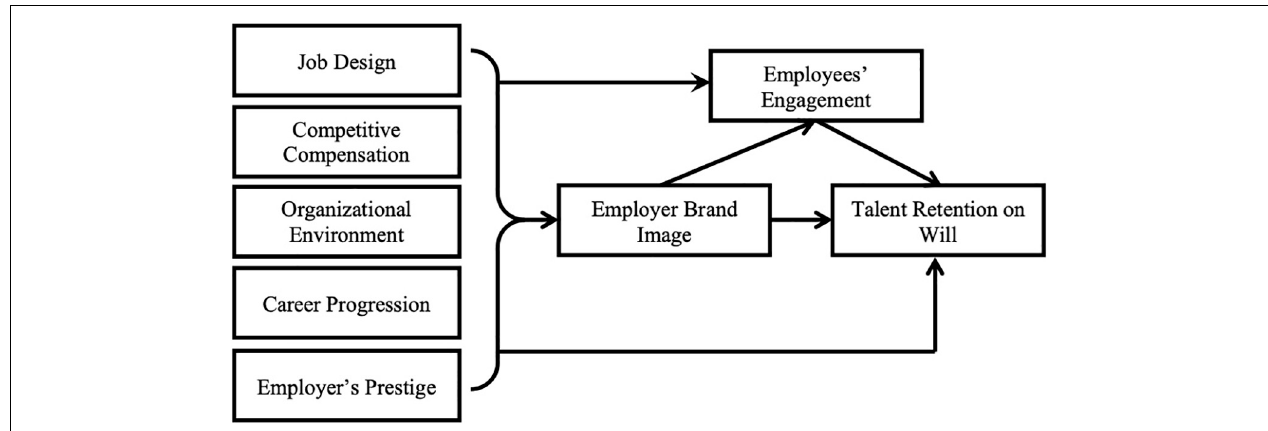
FIGURE 2 | The final conceptual framework (Minchington, 2010; Jiang and Iles, 2011; Priyadarshi, 2011; Inceoglu and Warr, 2012; Truss et al., 2012; Chhabra and Sharma, 2014; Singh and Rokade, 2014; Sukriket, 2014; Beck and Kenning, 2015; Jain and Bhatt, 2015; Stokes, 2015; Tanwar and Prasad, 2016; Wang, 2016; Carpentier et al., 2017; Saraswathy and Balakrishnan, 2017; Urbancova et al., 2017; Vorina et al., 2017; Akhir et al., 2018; Astrachan et al., 2018; Davies et al., 2018; Kaur et al., 2018; Nie et al., 2018; Okolo et al., 2018; Rubenstein et al., 2018; Sageder et al., 2018; Sharma and Prasad, 2018; Syed et al., 2018; Arasanmi and Krishna, 2019; Deepa and Baral, 2019; Dut˛u and Butucescu, 2019; Kamel, 2019; Madu et al., 2019; Qureshi, 2019; Tian and Robertson, 2019; West et al., 2019).